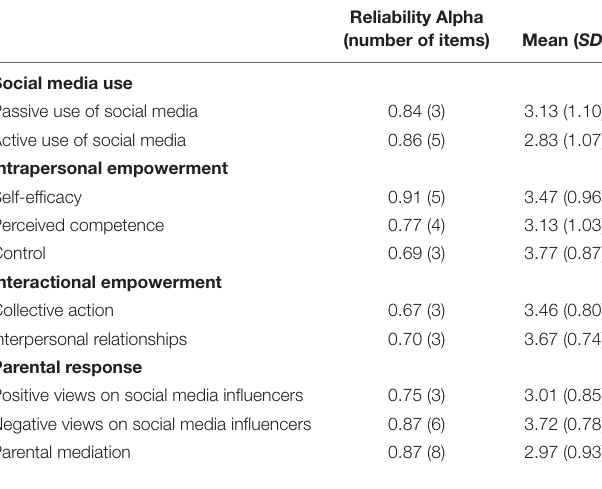
TABLE 2 | Descriptive statistics of the independent and dependent